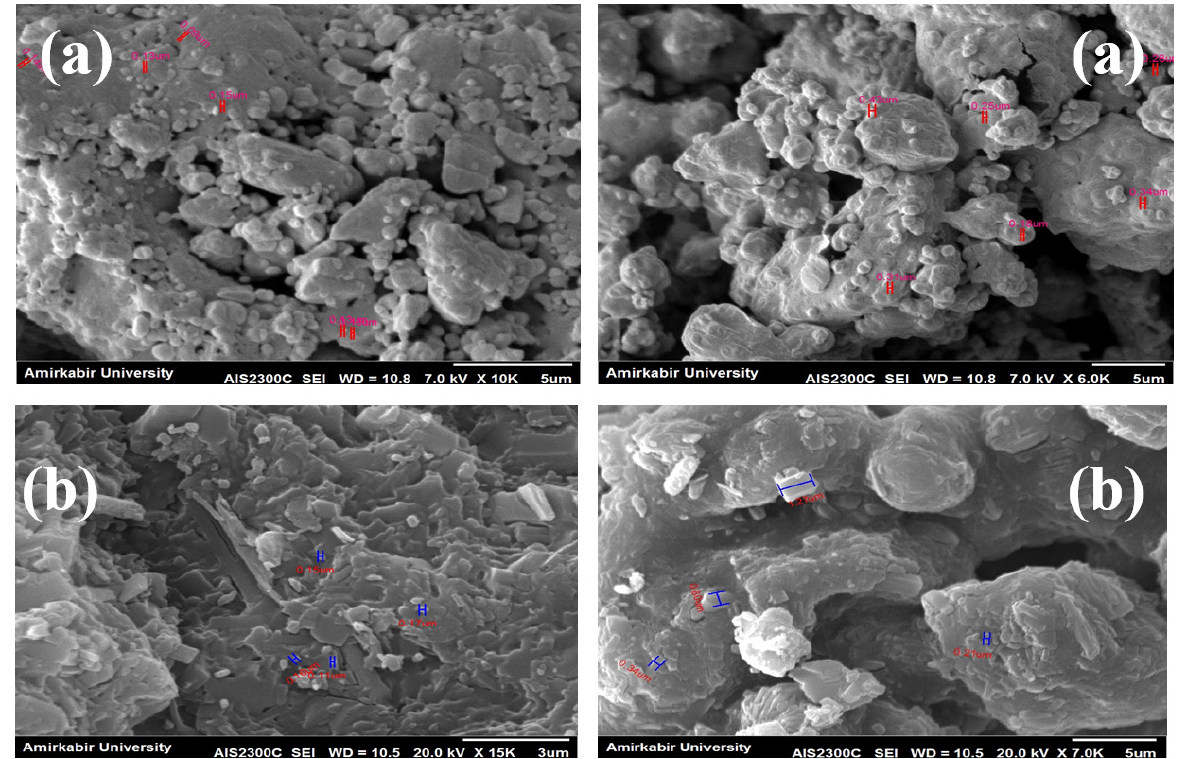
Figure 3: (a) SEM pictures of CAP-NP with magnification 7.0 kv ( b ) Ce 3+ doped CAP-NP with magnification 20.0